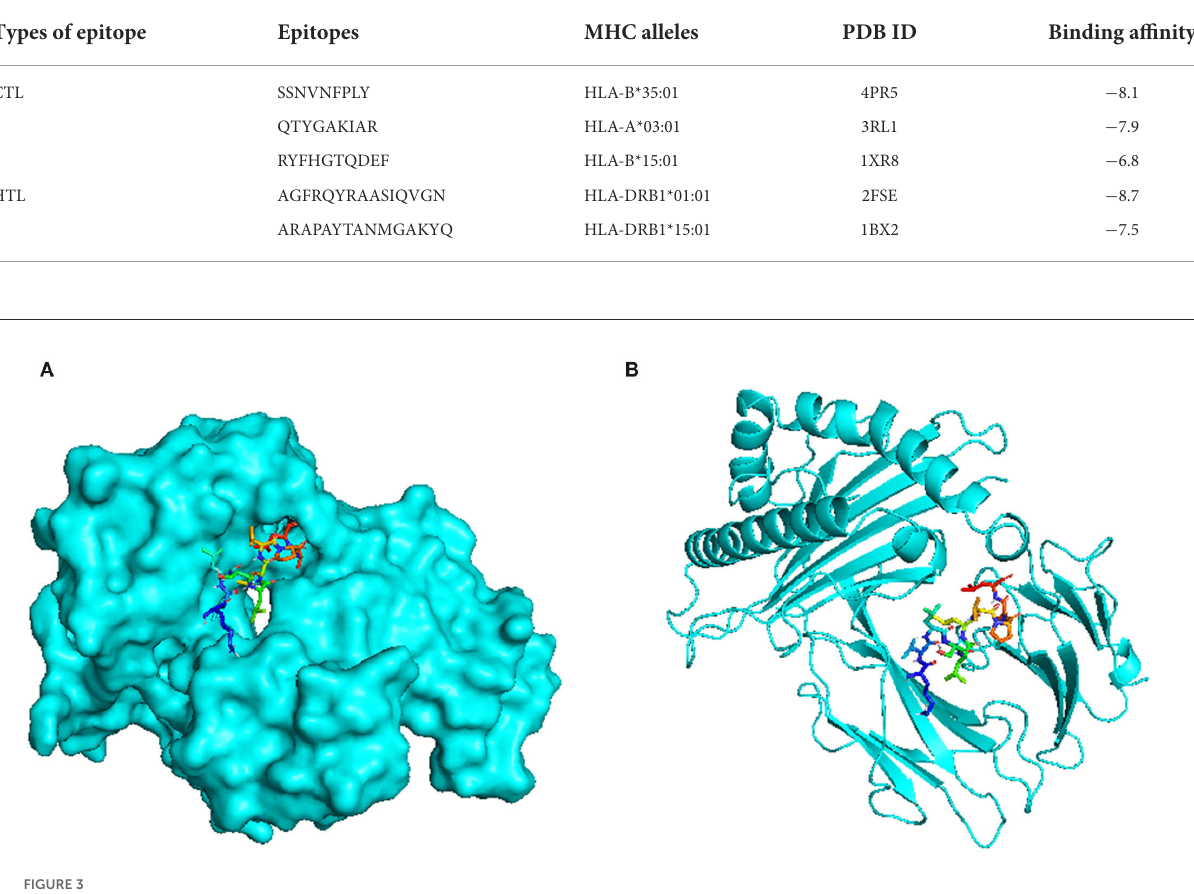
and capable of inducing IL-4, INF- γ , and IL-10, were selected. As shown in Table 1, 16 potential cytokine-triggering epitopes in a conserved area were